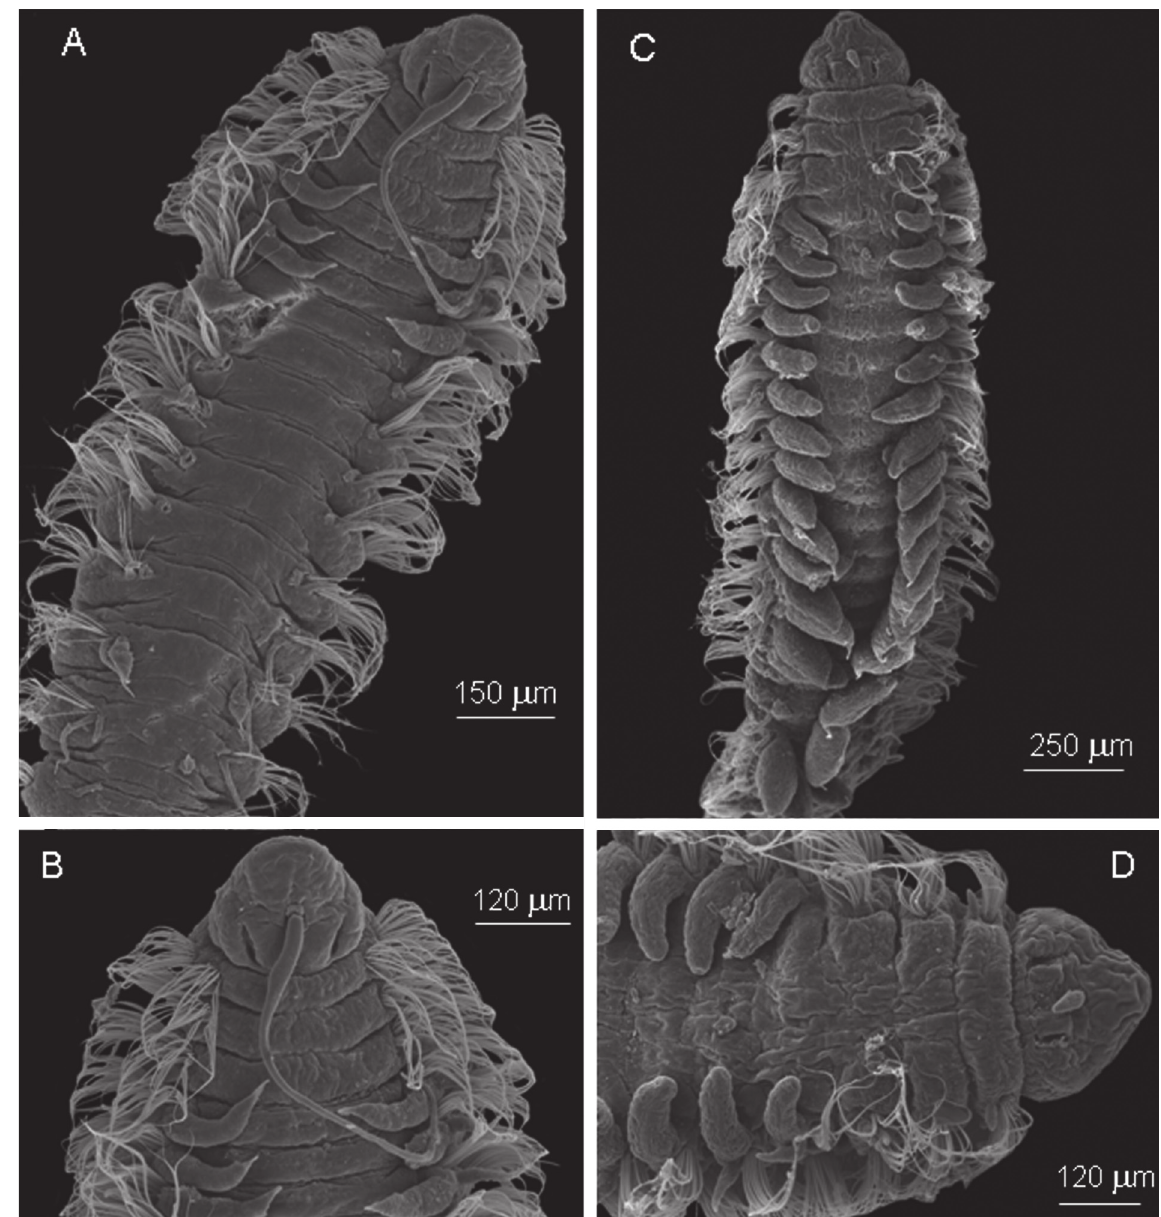
Fig . 23. – Aricidea ( Allia ) maialenae n. sp.: A-b, anterior region, dorsal view. Aricidea ( Allia ) nekanae n. sp.: c-D, anterior region, dorsal view. Scale bar: A 150 µ m; b 120 µ m; c 250 µ m; D 120 µ